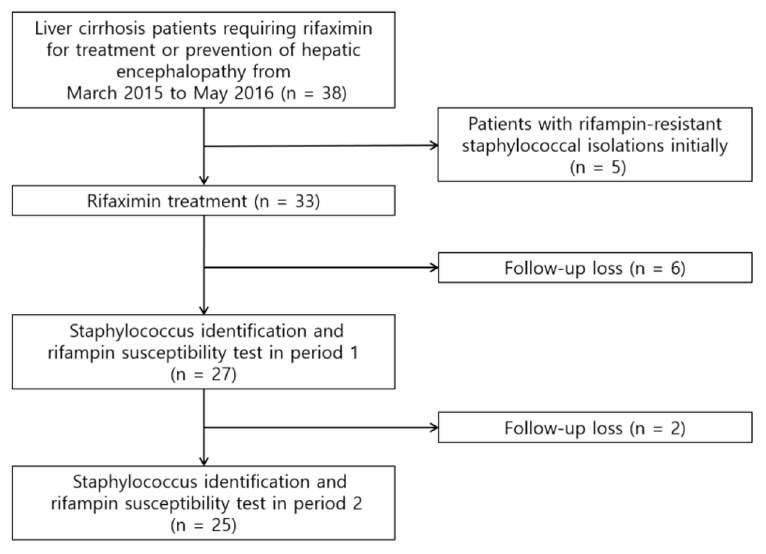
Fig 1. Flow chart of the study